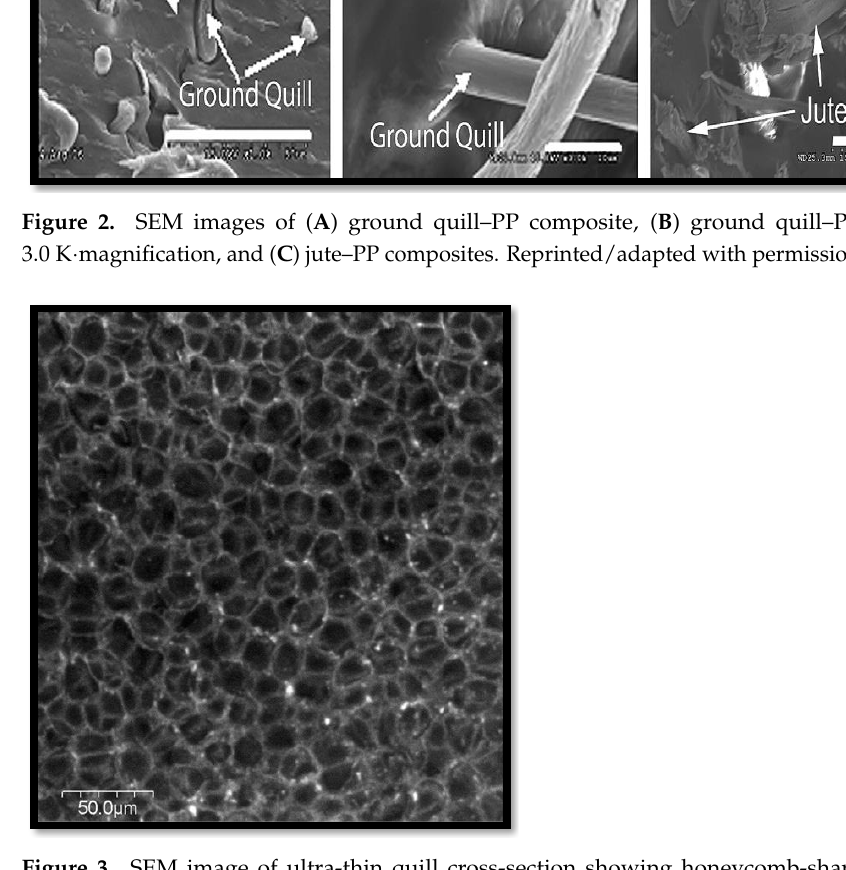
Figure 3. SEM image of ultra-thin quill cross-section showing honeycomb-shaped air pockets. Reprinted/adapted with permission from Ref. [48]. .